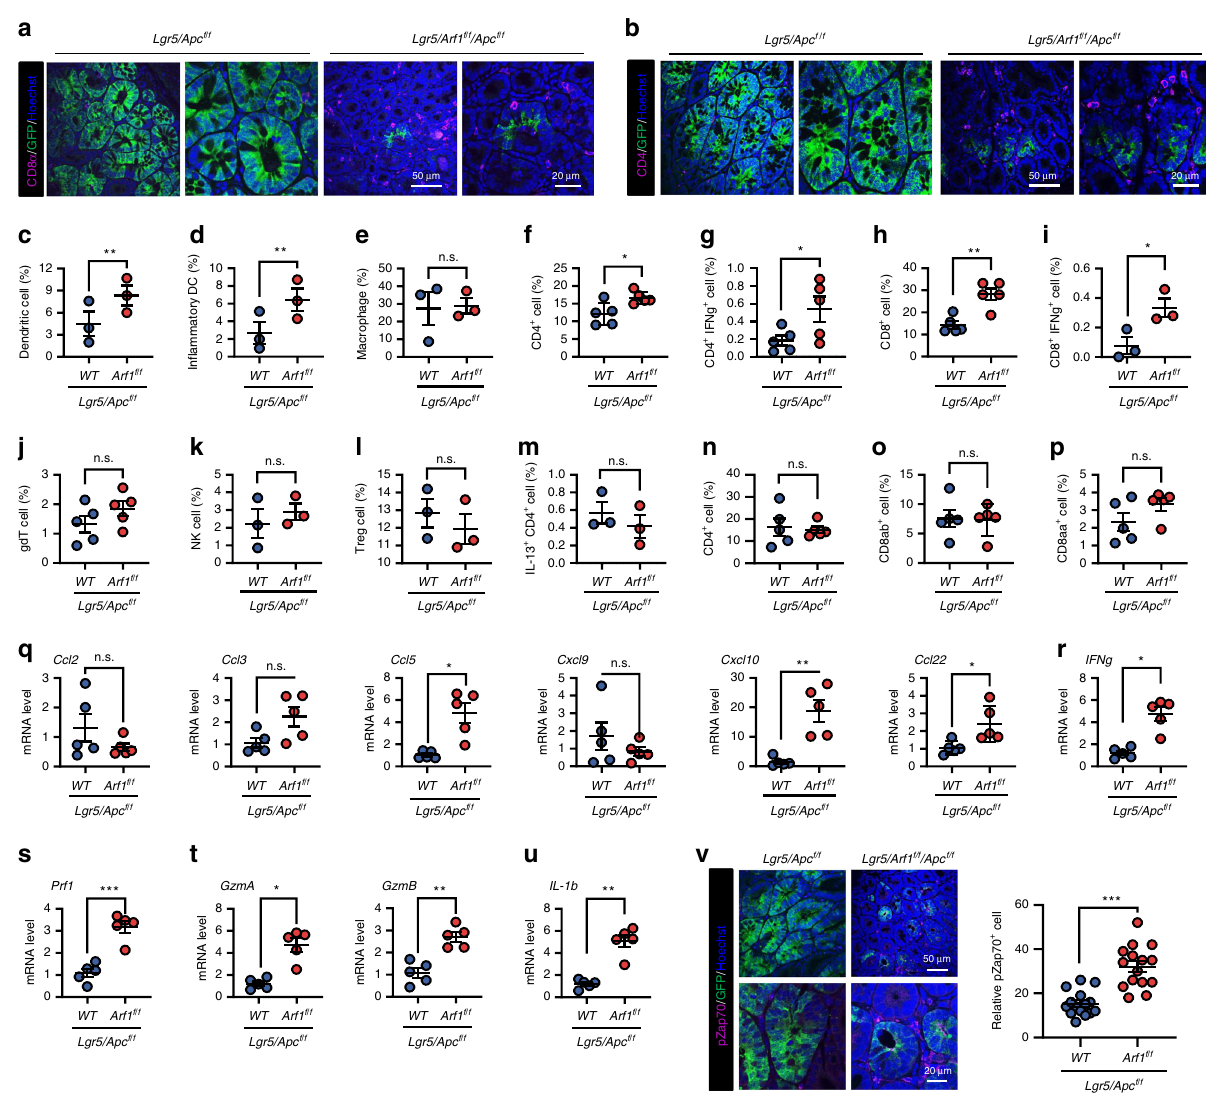
Fig. 2 Arf1 ablation induces the in fi ltration and activation of immune cells in Lgr5/Apc mice. a , b Immuno fl uorescent staining of GFP and CD8a ( a ) or CD4 ( b ) in the intestine of the indicated mice. c – e Flow cytometric analysis of gut APCs: DCs ( c ), in fl ammatory DCs ( d ), and macrophages ( e ) ( n = 3 mice each group; ** p < 0.01, t -test; repeat two independent experiments). f – m Flow cytometric analysis of the immune cells of LPLs: CD4 + T cells ( f ), IFN γ + CD4 + T cells ( g ), CD8 + T cells ( h ), IFN γ + CD8 + T cells ( i ), γδ T cells ( j ), NK cells ( k ), Treg cells ( l ), and IL-13 + CD4 + T cells, ( m ) ( n = 3 or 5). n – p Flow cytometric analysis of the immune cells of IELs: CD4 + T cells ( n ), CD8 αβ + T cells ( o ), and CD8 αα + T cells ( p ) ( n = 5 mice per group; * p < 0.05, ** p < 0.01, t- test; repeat two independent experiments). q – u Relative gene expression of the indicated chemokines, cytokines, and granzymes ( n = 5 mice each group, repeat two independent experiments). v Immuno fl uorescent staining of GFP and pZap70 in the intestine of the indicated mice ( n = 5 mice each group; * p < 0.05, ** p < 0.01, *** p < 0.001, t -test; repeat two independent experiments). Each experiment replicate two times. Data are shown as the mean ± SEM. Scale bars are as